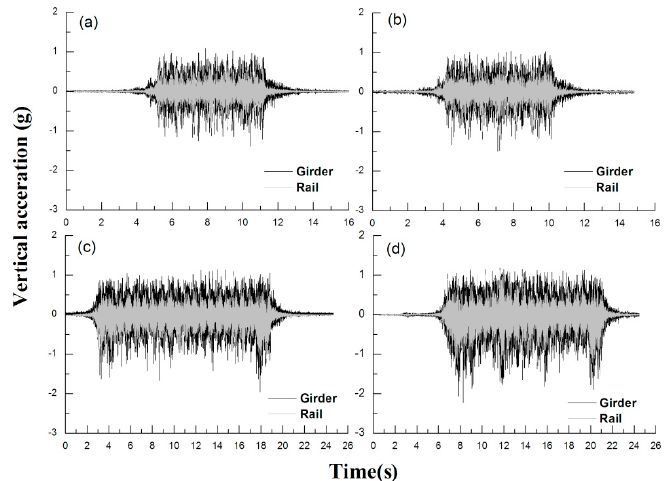
Figure 12. Comparison of the measured vertical acceleration of the rail and track girder. ( a ) Before rail pad replacement for AREX; ( b ) after rail pad replacement for AREX; ( c ) before rail pad replacement for KTX; and ( d ) after rail pad replacement for KTX.